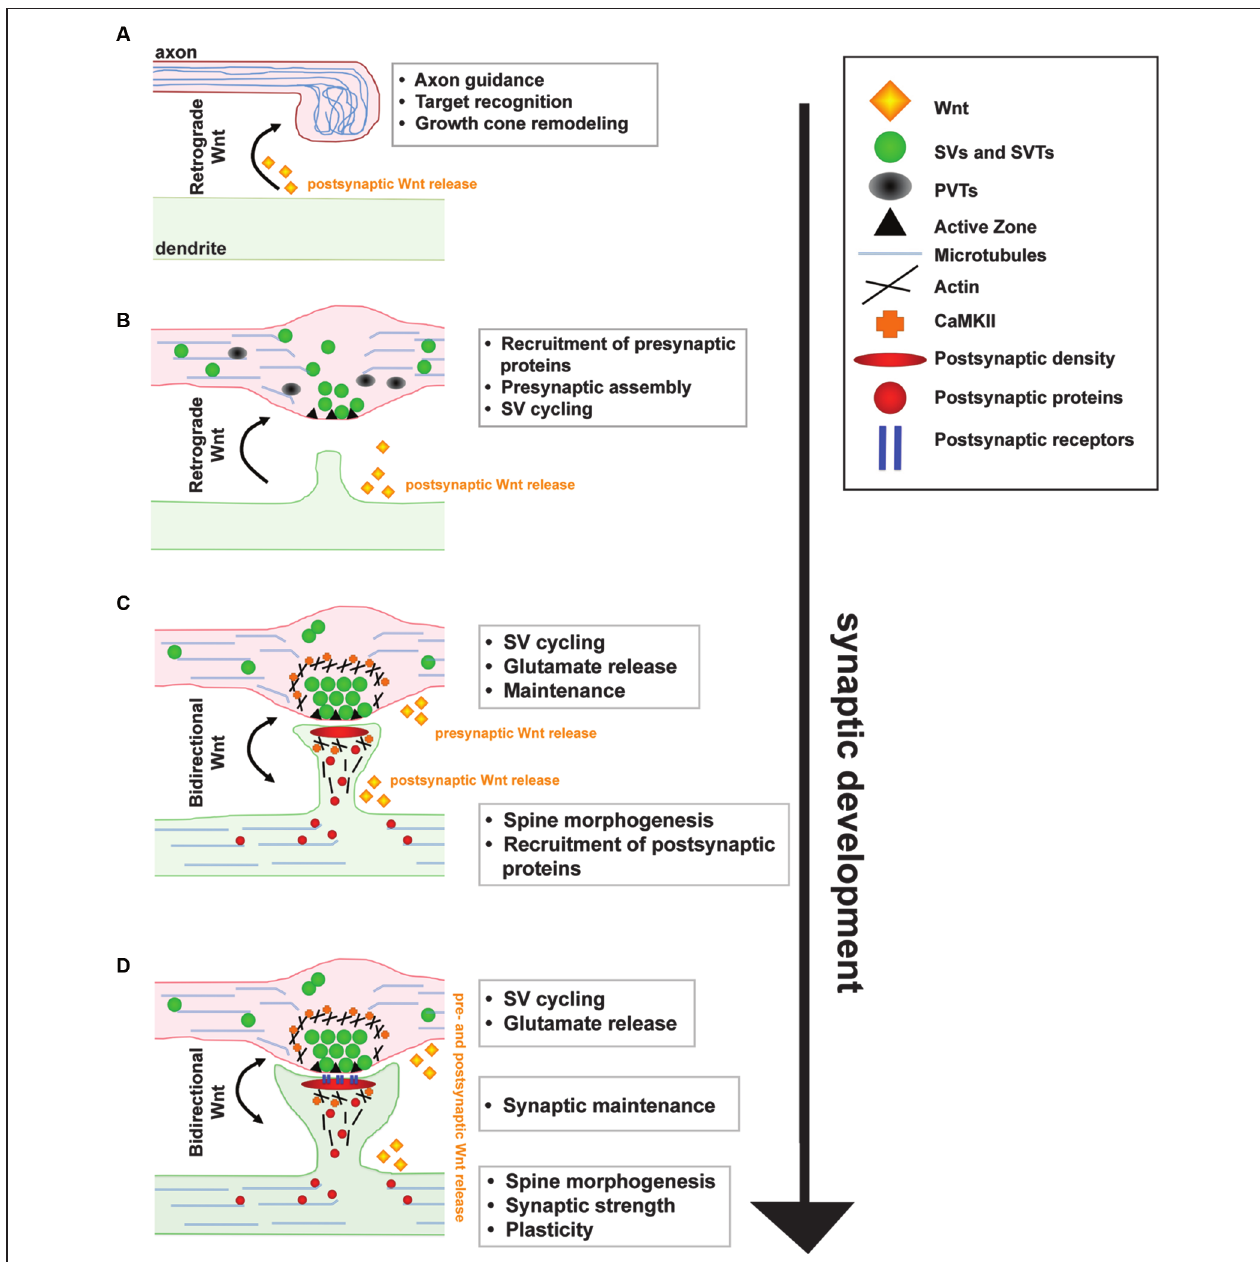
proteins resulting in the formation of synaptic boutons. (C) Wnt also signals directly to the postsynaptic dendrite through CaMKII to stimulate spine morphogenesis, postsynaptic protein recruitment and synaptic strength. (D) At mature synapses, Wnt signaling regulates synaptic function and